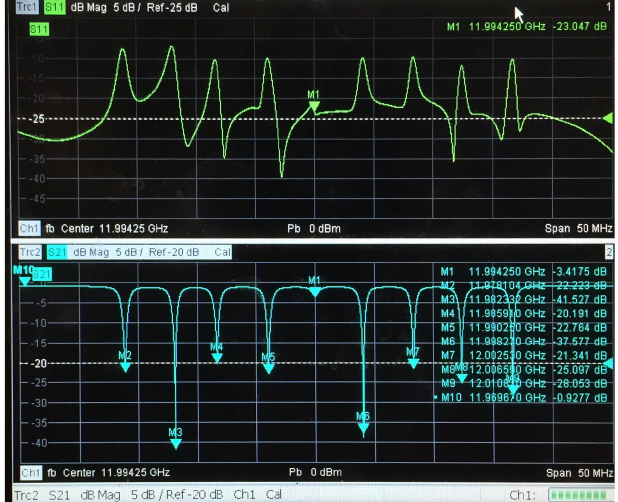
FIG. 6. The spectrums of the pulse compression system including the CC, the BOC and the connecting